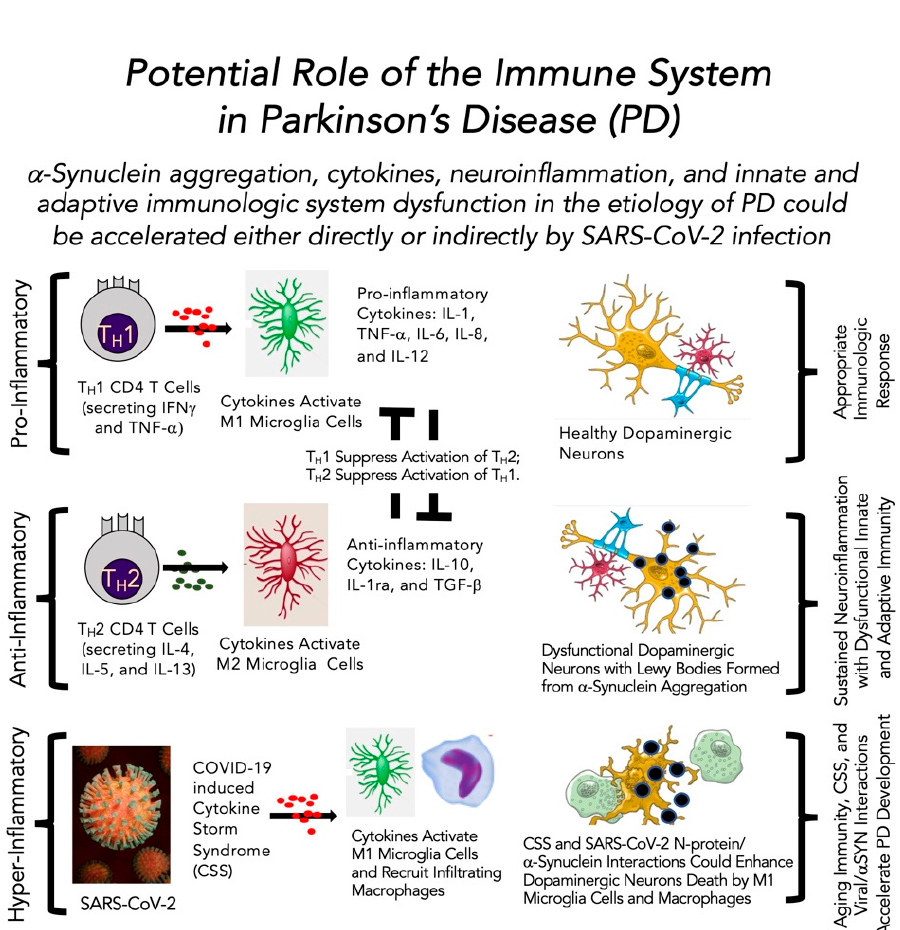
Figure 3. The role of the immune system in the development of PD. The top-left panel shows the adaptive immune system in promoting a pro-inflammatory state. The middle-left panel is the anti-inflammatory reaction to temper down the first reaction. The bottom-left panel shows the activation of adapting immune cells from SARS-CoV-2 hyper-inflammation. The top- , middle- , and bottom-right panels show the immunological consequences of the appropriate and inappropriate reactions of the immune system cells, respectively (dark-colored dots represent aggregated α